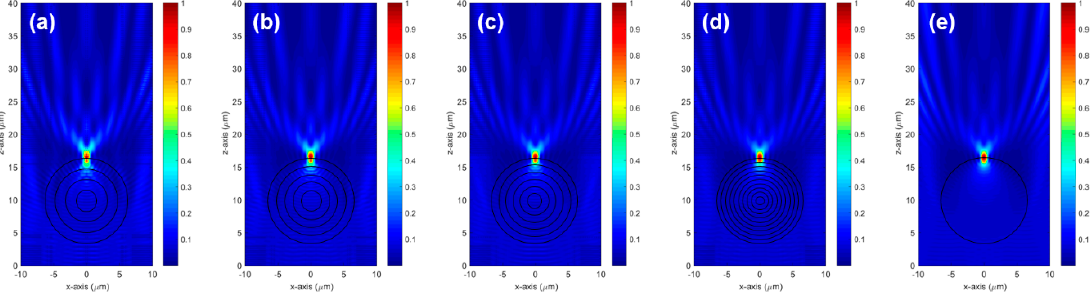
Figure 3. Simulated intensity distributions of Luneburg lenses with the ELS index profile: ( a ) N = 4, ( b ) 5, ( c ) 6 and ( d ) 10, respectively. Larger N s (>6) show almost the same response as a Luneburg lens with a continuous GRIN profile. The intensities are normalized. Concentric circles depict the step boundary of the index profile in ( a ); Here, the smallest step number for an optimal performance ( N opt ) is determined to be 5; ( e ) The result of the continuous-profile device shows an identical result as that of N = 10 shown in ( d ).